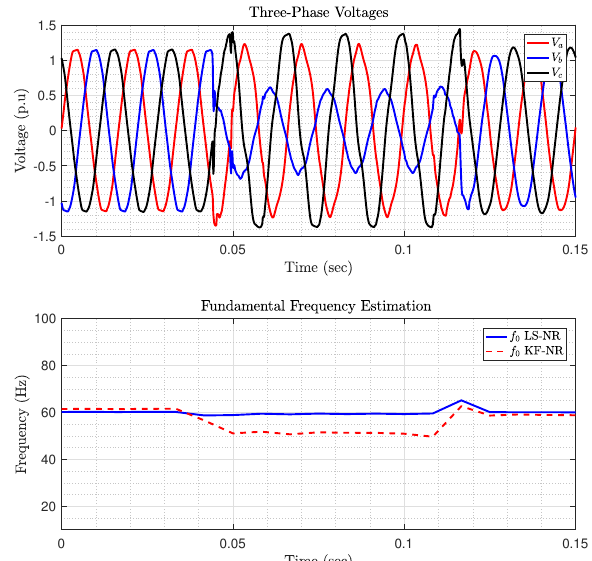
Figure 5. Three-phase voltages and estimated frequency (event 2911).